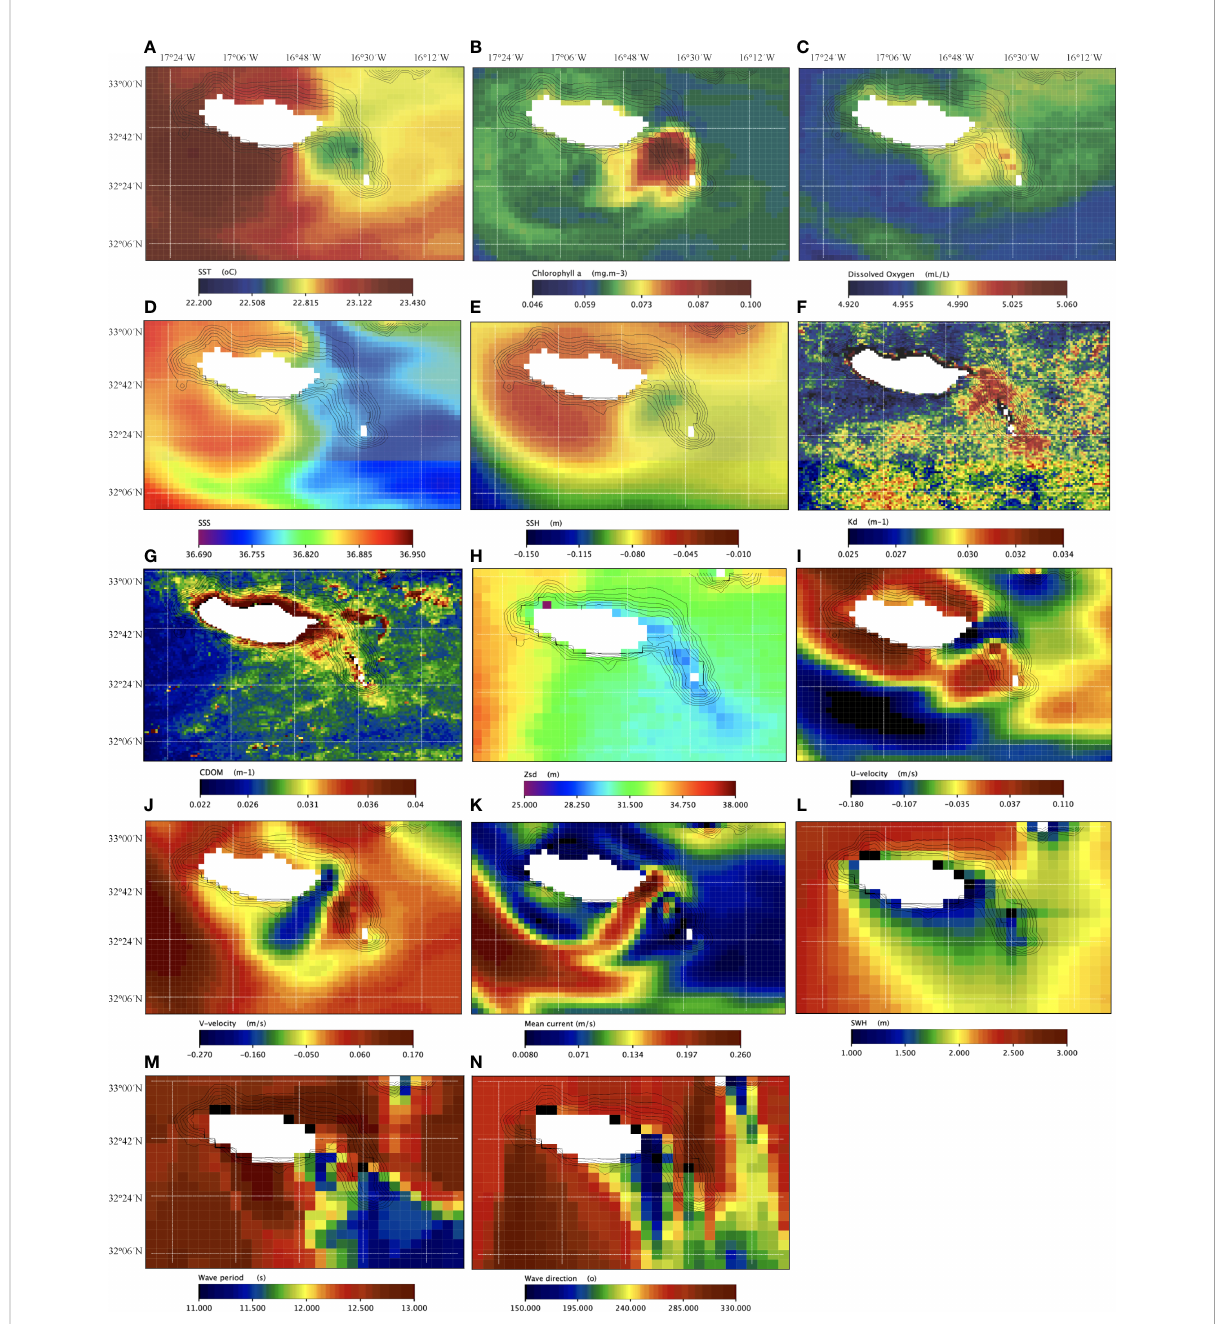
FIGURE 4 Monthly mean MODIS/AQUA-derived products for the Madeira archipelago: (A) sea surface temperature (SST, in °C); (B) chlorophyll- a (mg.m -3 ); (C) dissolved oxygen (mL.L -1 ); (D) sea surface salinity (SSS, in PSU); (E) sea surface height (SSH, in m); (F) volume attenuation coef fi cient of downwelling radiative fl ux in seawater at 490nm (Kd 490 , in m -1 ); (G) coloured dissolved organic matter (CDOM in m -1 ); (H) Secchi disk depth (Z sd , in m); (I) eastwards sea surface water velocity (u-velocity, in m.s -1 ); (J) northwards sea surface water velocity (v-velocity, in m.s -1 ); (K) mean current (in m.s -1 ); (L) signi fi cant wave height (SWH, in m); (M) wave mean period (s); and (N) mean wave direction from north